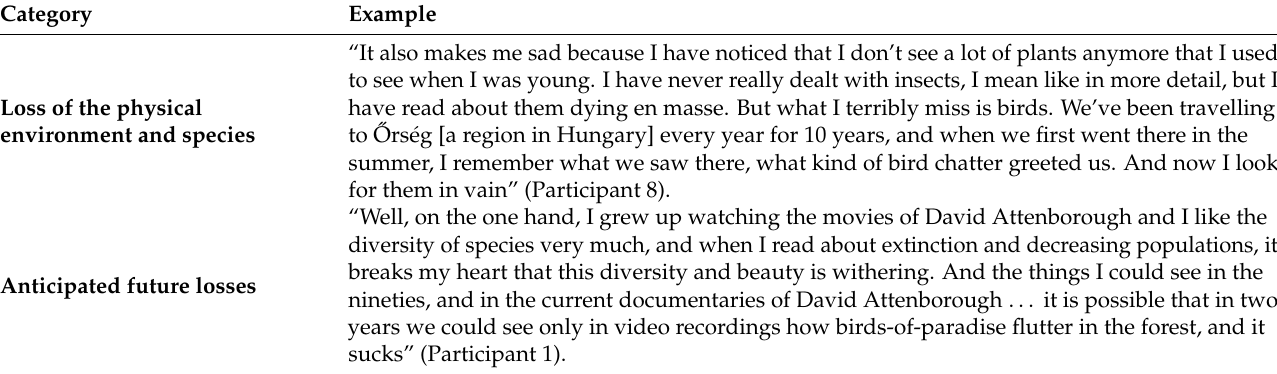
Table 4. Examples for